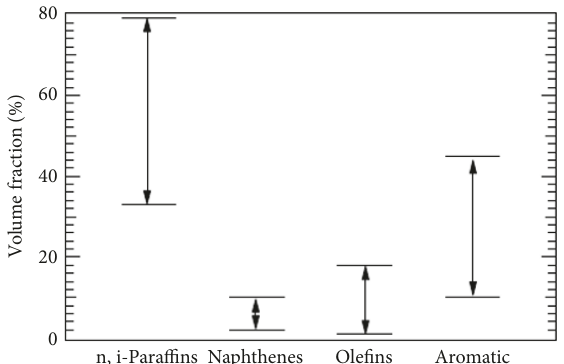
Figure 7: Approximate ranges of paraffins, naphthenes, olefins, and aromatics in commercial US gasoline. Figure is adopted from Pitz et al. [26].